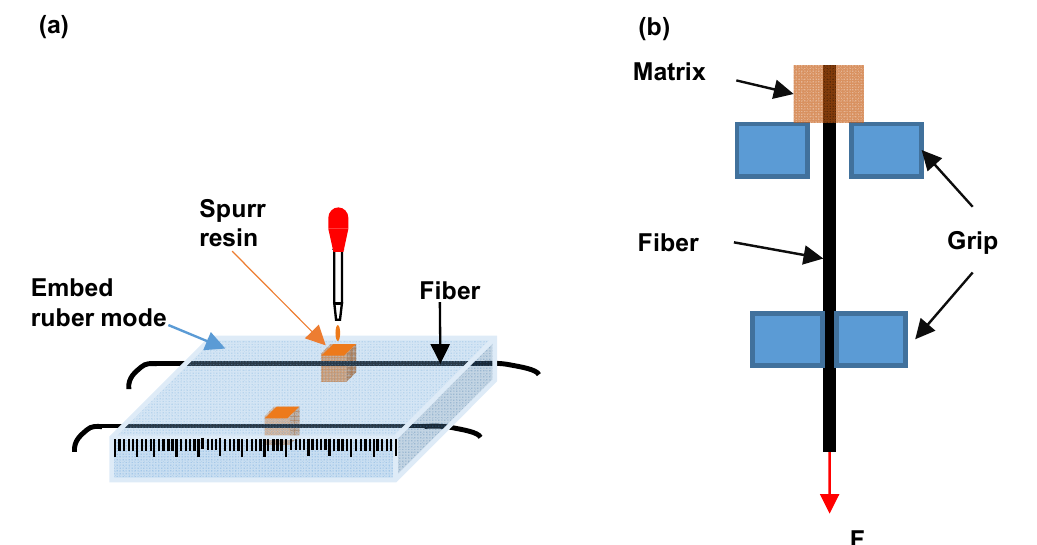
Figure 1. Schematic diagram of the single fiber pull-out test ( a ) fiber embedding; ( b ) fiber pull-out.